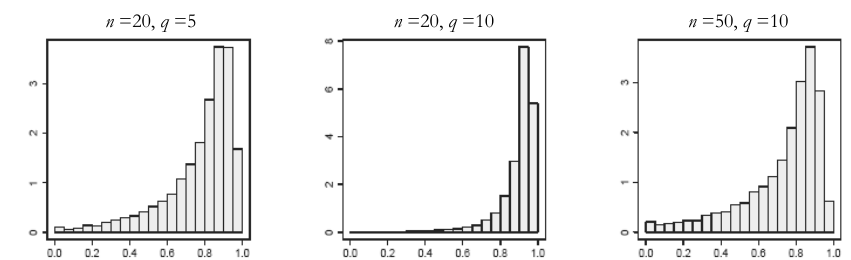
Figure 9 – qp -hist plots and associated distributions of the non-rejection rate for present and missing edges of G 2 = ( V , E 2 ), resulting from the application of the qp -procedure for different values of n and q